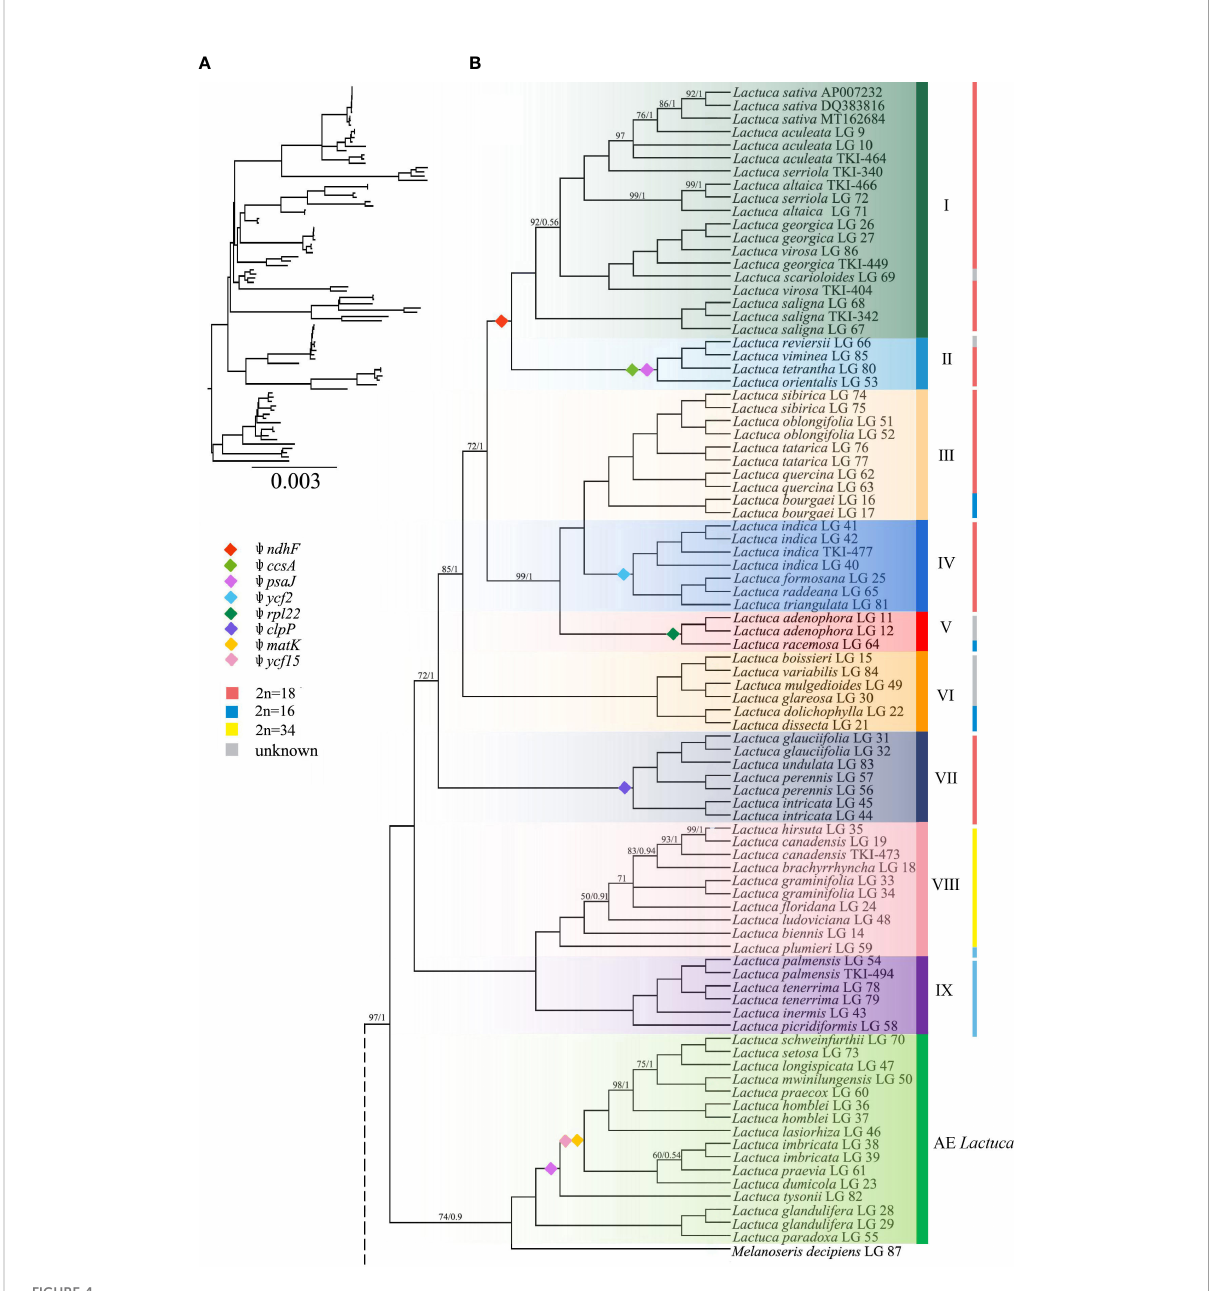
FIGURE 4 Phylogenetic tree of Lactuca and AE Lactuca species inferred from plastomes. (A) Phylogenetic tree with branch length. (B) ML/BI tree, the color is consistent with that in Figure 3. The nodes with full support (BS = 100, PP = 1) are not shown. The information on pseudogene and reverse SSC is indicated on the branches. The vertical line on the right represents the number of chromosomes. Support values are maximum likelihood bootstrap (BS) / Bayesian posterior probability (PP). No support values are shown for nodes with full support (BS = 100, PP =